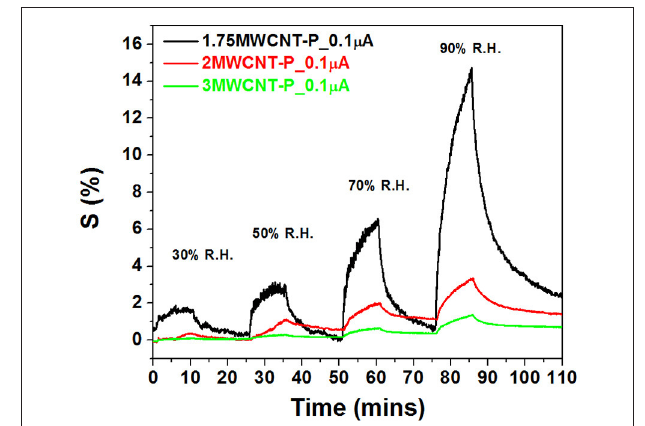
FIGURE 6 | Sensing results of samples at room temperature. The humidity was increased in each sensing